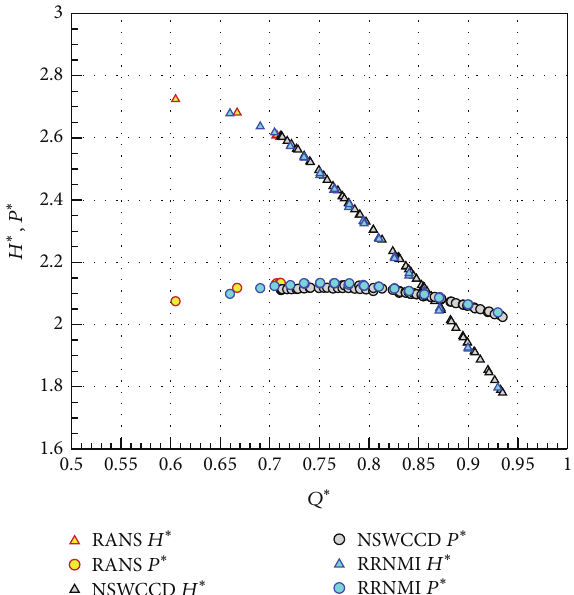
Figure2:FullywettedRANSpredictionscomparedtoexperimental measurements inside cavitation tunnels at NSWCCD and